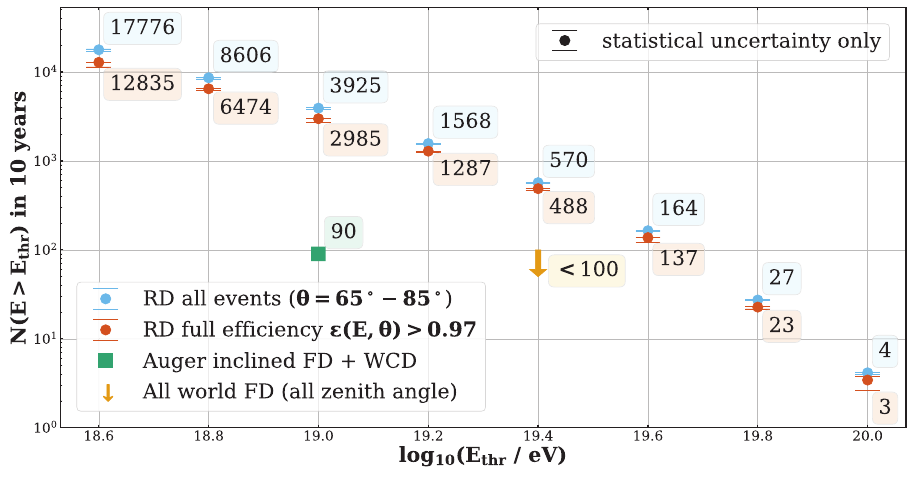
Figure 5. Integral number of cosmic rays expected to be detected by the Auger Radio Detector for a measurement period of 10 years. Blue points denote all detected events, red points only those in bins of energy and zenith angle for which the detection e ffi ciency is at least 97%. For comparison, the number of inclined air showers measured with both the Auger Surface and Fluorescence Detectors is shown in green [18], and the total statistics of air showers measured with Fluorescence Detectors worldwide at energies of 10 19 . 4 eV or higher is shown in yellow